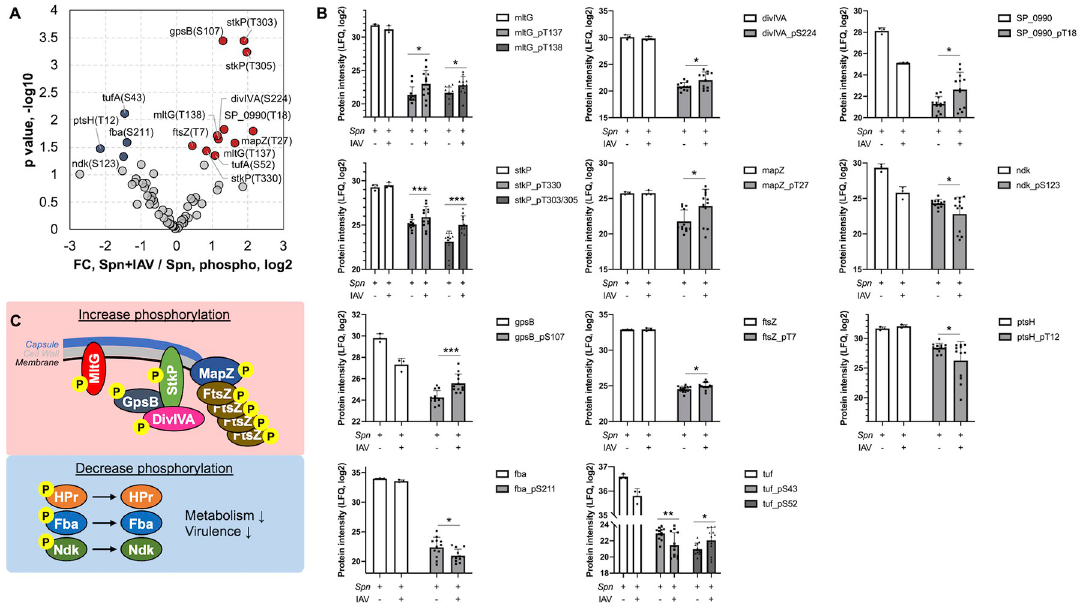
Fig 3. Change in Spn phosphoproteome in the presence of Influenza virus. ( A ) Volcano plot showing fold changes of phosphopeptides vs their p-values. Significantly changed phosphopeptides are shown in red (up-regulated) and blue (down-regulated) in the presence of IAV (Student’s t-test � = p � 0.05; �� = p � 0.01; ��� = p � 0.001). ( B ) Peptide counts of the unmodified (white) and phosphorylated (gray) forms of indicated proteins in the absence or presence of IAV. Data reflect mean ± SD. ( C ) The top scheme shows the proteins with increased phosphorylation, most of which are known to localize to the septum during cell division. The bottom blue square shows proteins that are downregulated in phosphorylation, and their related functions.